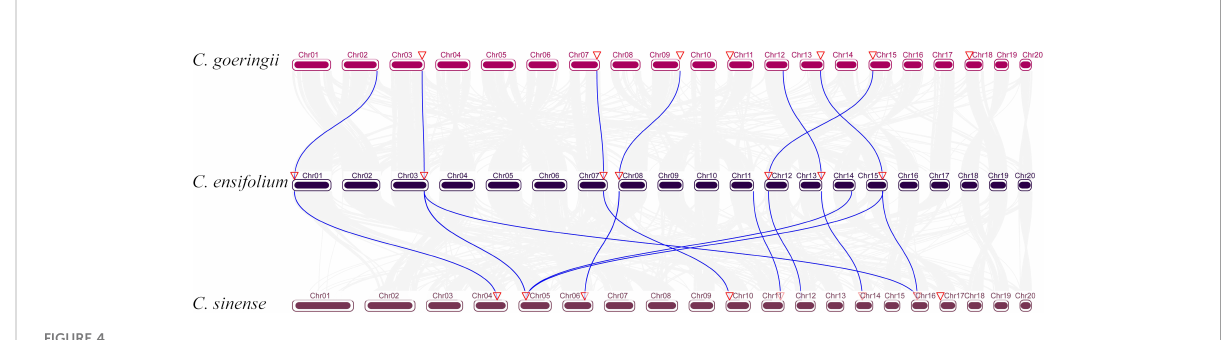
FIGURE 4 Collinear correlation analysis in three Cymbidium species.